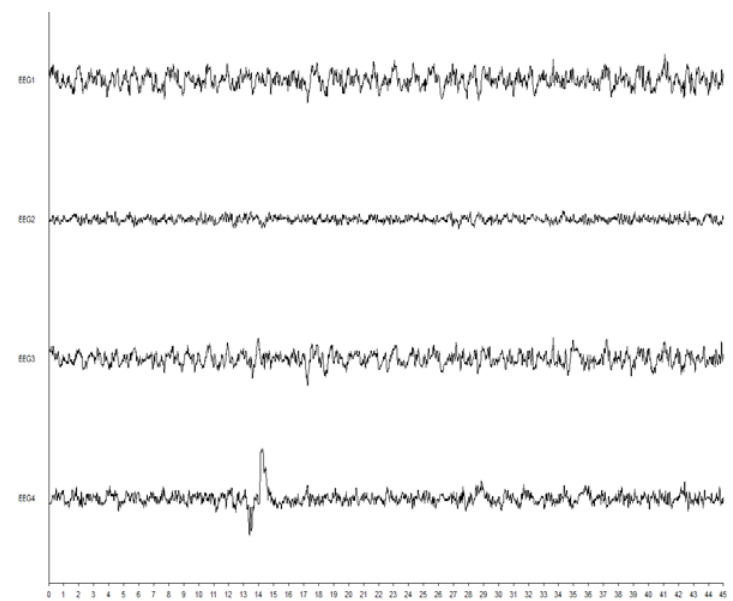
Figure 4. Epileptiform activity during increase in RE and SE values at fifth stage of VIGA with sevoflurane using VIMA technique.